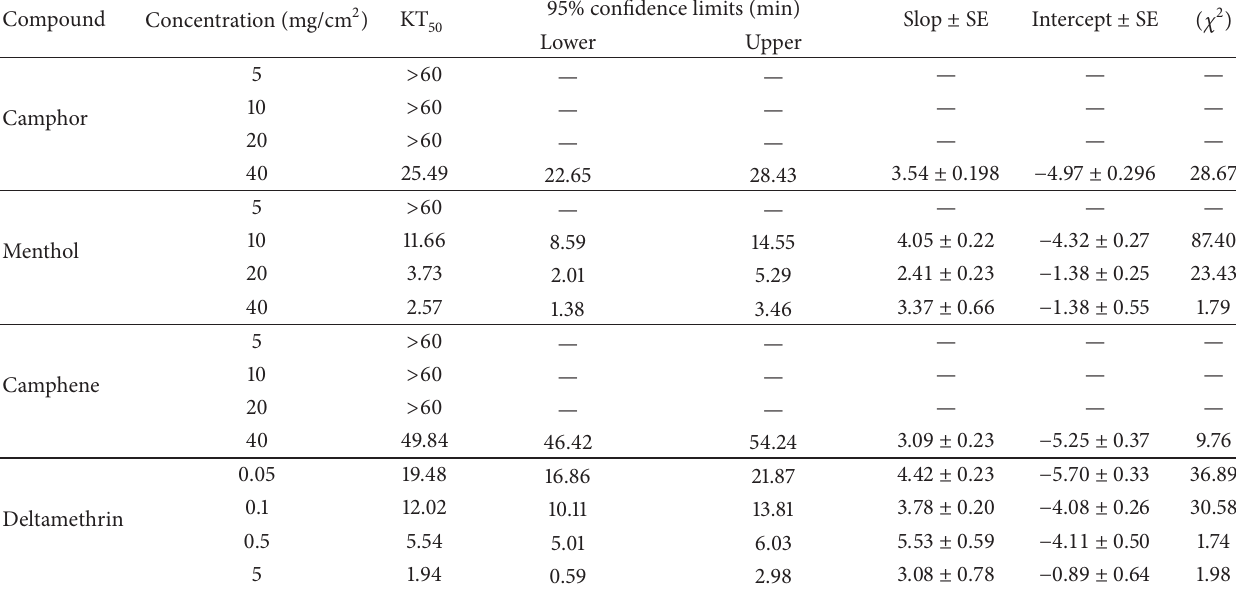
Table 4: Knockdown time (KT 50 ) of single monoterpenes at different concentrations (mg/cm 2 ) against the female adult Cx. pipiens as determined by residual assay.